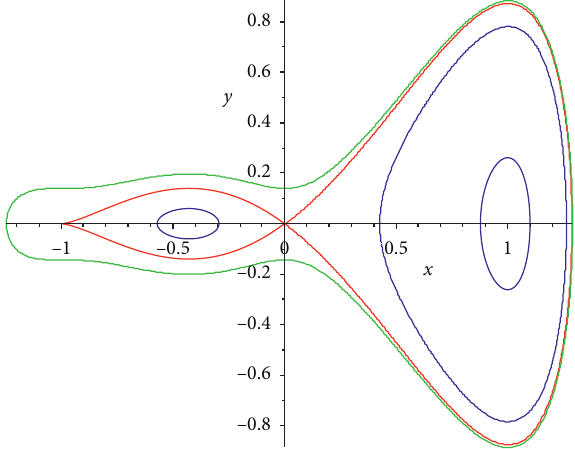
Figure 1: The portrait of system (6) when ε �